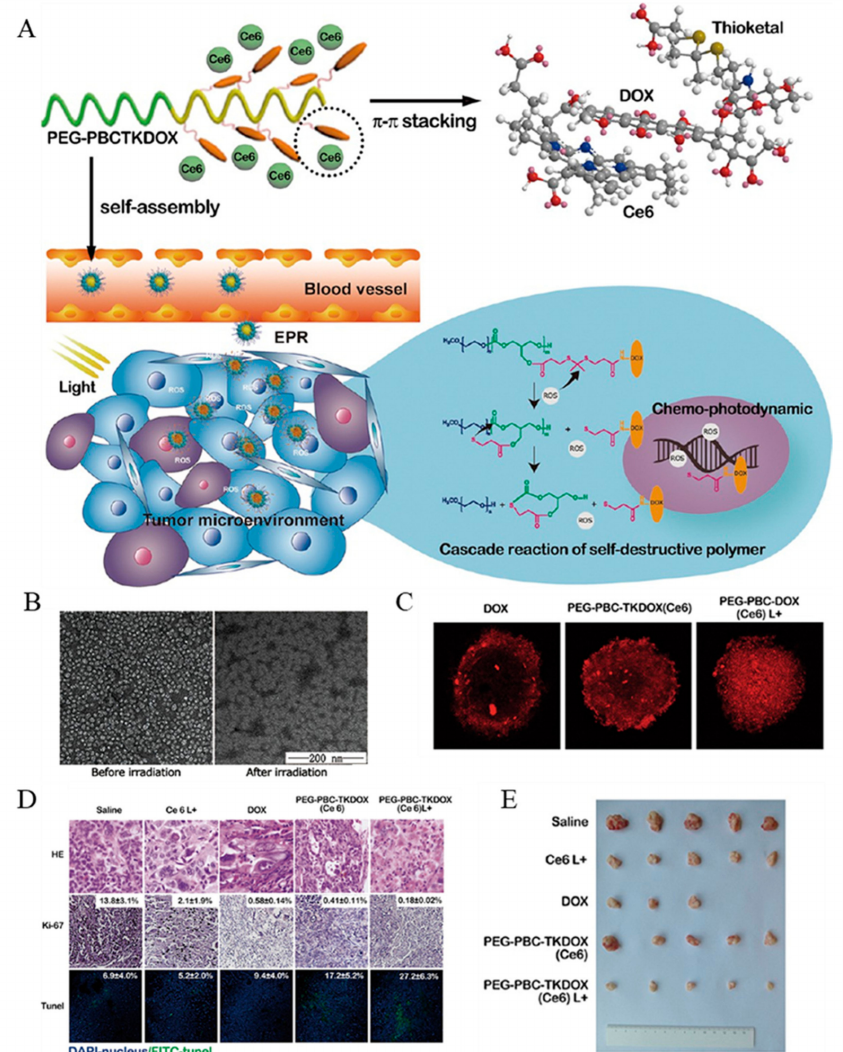
Figure 6. ( A ) Schematic of the cascade reaction of self-destructive polymeric nanomicelles. ( B ) zeta- potential of Ce6-loaded PEG-PBCTKDOX nanomicelles. ( C ) Penetration of DOX in MCF7/ADR 3D cell spheroids. ( D ) Tumor images of H&E staining, Ki67 immunohistochemistry, and TUNEL assay after the treatment depicting morphology, proliferation, and apoptosis, respectively. ( E ) Final tumor volume images after different drug treatment. Adapted from